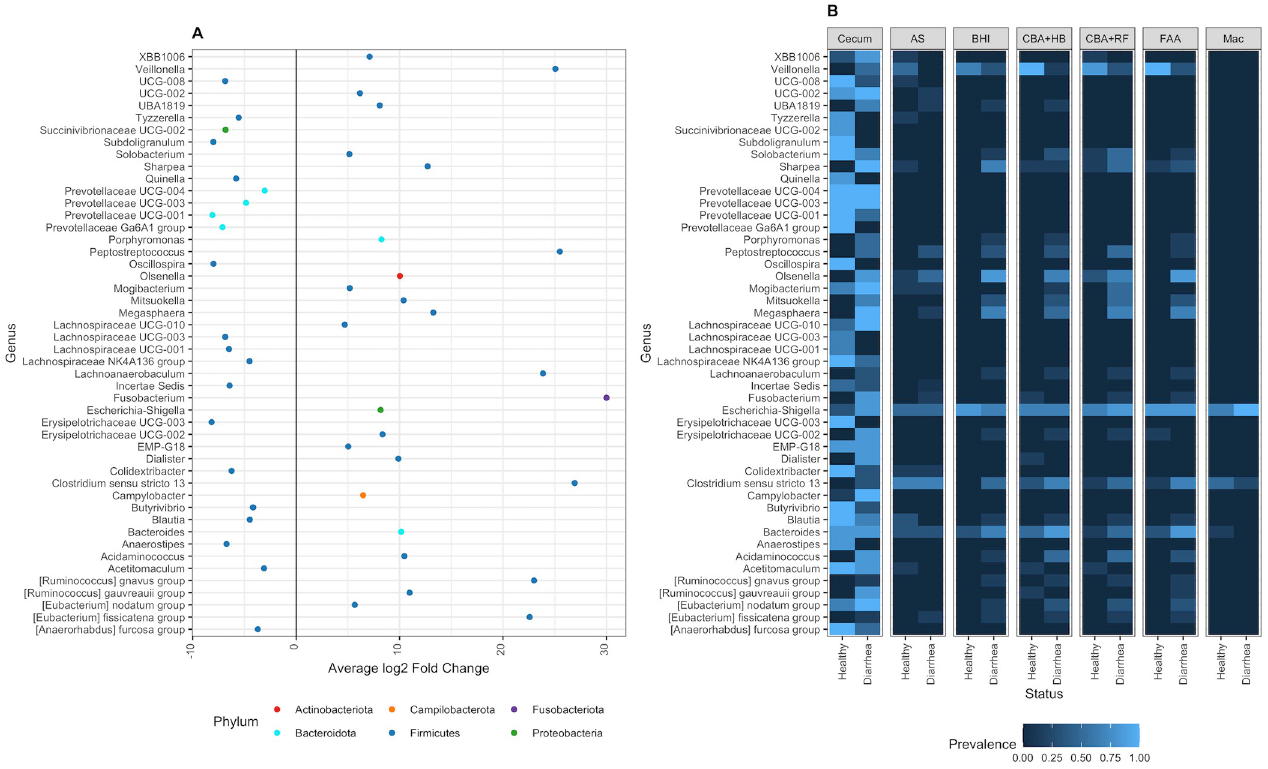
Fig 9. Differential abundance analysis to the cecum genus level bacteria of diarrheic horses showing the difference in abundance of each genus compared to healthy horses (A). The prevalence of significant genera in cecum and cultured samples (B). Abbreviations: MacConkey agar (Mac), fastidious agar with horse’s blood added (FAA), Columbia agar with horse’s blood added (CBA+HB), Columbia agar with rumen fluid added (CBA+RF), BHI3 with carbohydrate added (BHI), AS (samples plated on CBA+HB after alcohol shock), and Cecum (samples sequenced directly, without culture).